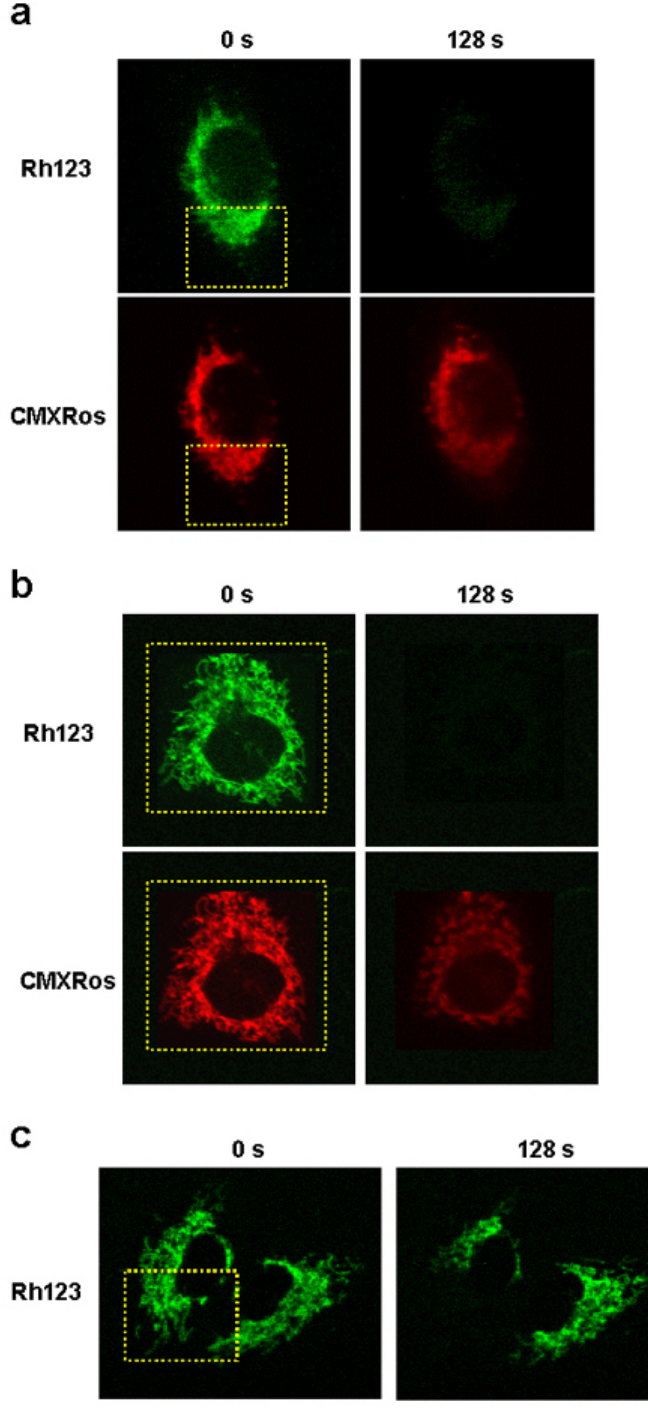
FIGURE 1 . Rapid loss of ∆Ψ m in cells subjected to partial or global irradiation using microscopic photosensitization. (a) Confocal imaging of human osteosarcoma 143B TK - cells before (0 s) and at end of partial irradiation (128 s) loaded with Rh123 (10 µ M) and CMXRos (200 nM). Dashed box denotes the area of the cell subjected to confocal laser irradiation for 128 s. ∆Ψ m response indicated by Rh123 is representative of 18 of 21 cells. (b) Imaging of cells subjected to global irradiation under same conditions as in (a). Loss of Rh123 signal in whole cell is representative of all 30 cells analyzed. (c) Control cells loaded with Rh123 were subjected to partial irradiation as in (a). Retention of Rh123 in nonirradiated mitochondria is representative of all 16 cells